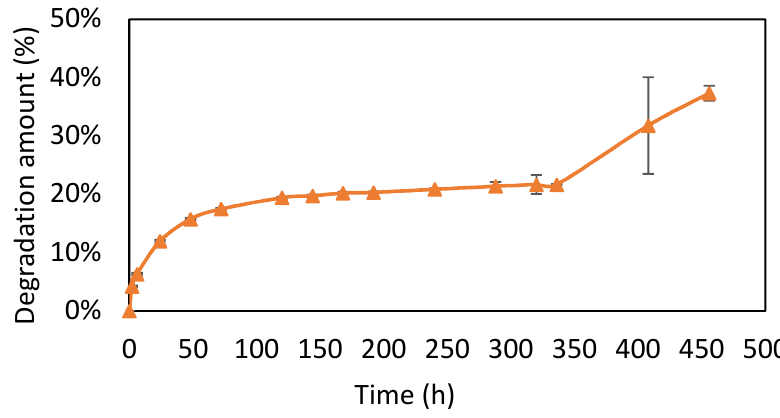
Figure 3. Degradation test ( n = 6). Data are expressed as means ± SD. The Gel/HA–HAP composite had three stages of degradation.